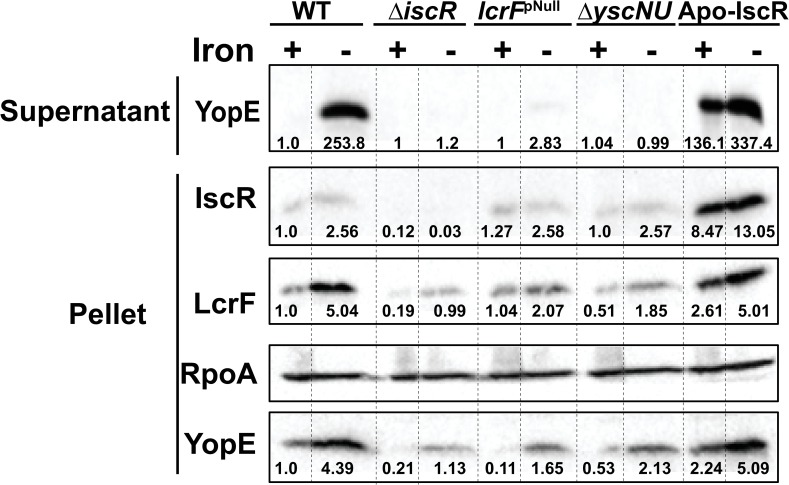
Iron limitation induces iscR, lcrF, and yopE expression under anaerobic respiration conditions.Iron-limited Y. pseudotuberculosis was shifted to iron-replete (+Fe) or iron-limited (-Fe) M9 media supplemented with sodium nitrate and mannitol in the absence of oxygen. Type III secretion was induced at 37°C for 4 hrs. T3SS cargo proteins secreted into culture supernatant and precipitated with TCA were probed with antibodies for YopE. Cell lysates were probed with antibodies for RpoA, YopE, and LcrF. All samples shown are from the same experiment, with each lysate split into two gels, one subsequently used for LcrF and YopE probing and the other for IscR probing. RpoA was used as a loading control. One representative experiment out of three is shown. Dotted lines delimit the area of each well. Densitometric quantification of the bands was performed using Image Lab software (Bio-Rad), setting the WT (+Fe) band to 1.00.